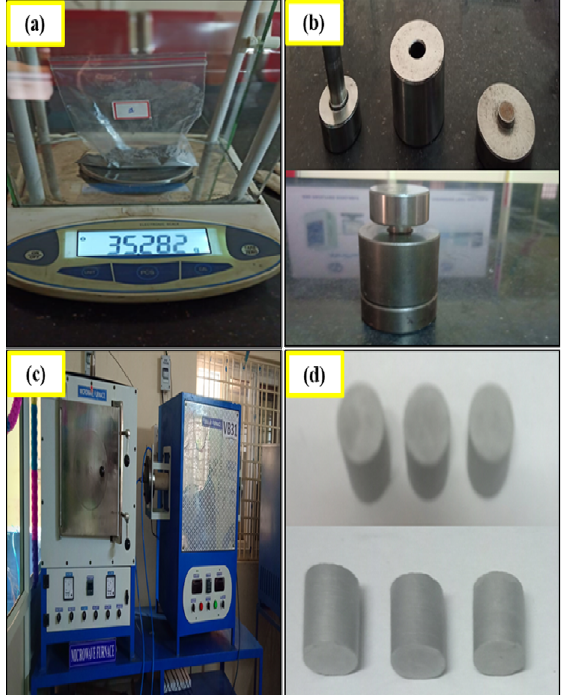
Figure 2. Photographs of different devices/tools used to produce of Al/Graphene/CNT composites (a) weighing balance, (b) compaction die, (c) tubular furnace for sintering and (d) sintered hybrid composite